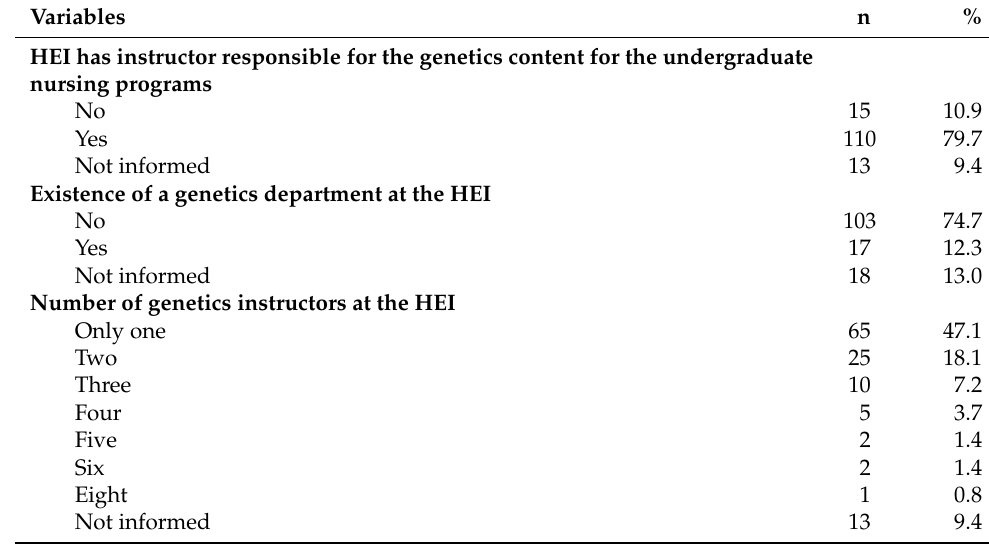
Table 1. Characterization of the HEIs regarding the existence of instructors and departments of